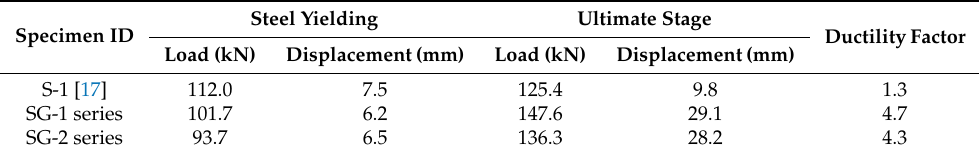
Table 7. Displacement ductility factor for RC slabs strengthened with TRC